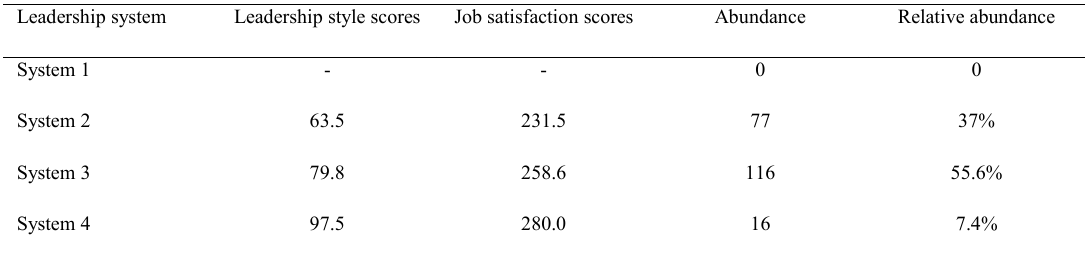
Table 2: distribution of leadership style and job satisfaction